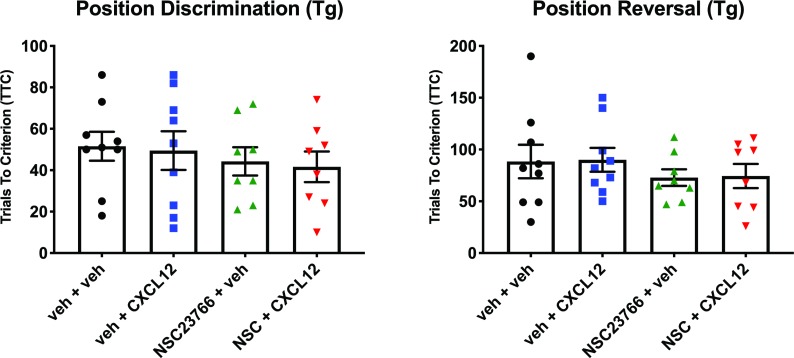
Inhibition of Rac1 activation by NSC23766 does not alter performance on position discrimination or position reversal in HIV-Tg rats.